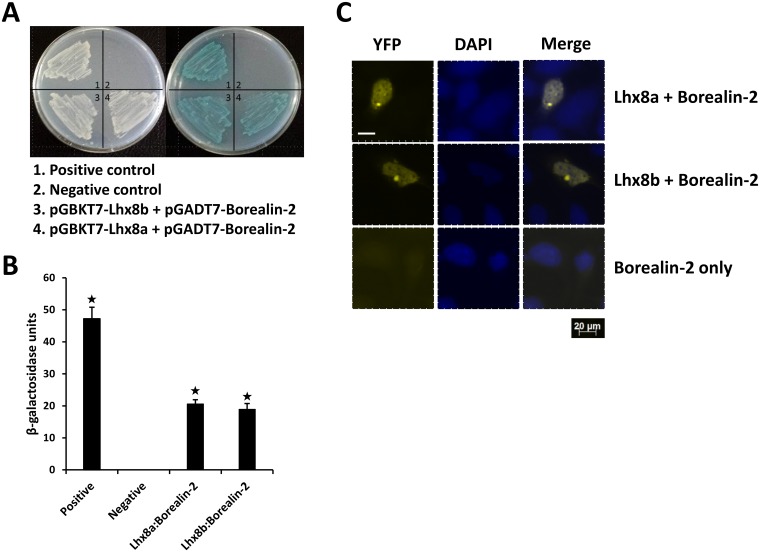
Analysis of interactions between Lhx8 proteins and Borealin-2.A: Yeast two-hybrid analysis showing growth of yeast cells expressing BD and AD fusion proteins. Left plate: growth of yeast cells on DDO plate (medium lacking Leucine and tryptophan) showing successful co-transformations. Right plate: growth of yeast cells on selective QDO/X/A plate (quadruple drop-out medium lacking leucine, tryptophan, adenine and histidine and containing X-gal and Aureobasidin A) indicating protein-protein interactions. B: Yeast β-galactosidase liquid assays confirming interactions between Lhx8 proteins and Borealin-2. Asterisks indicate significant difference (P<0.05). C: BiFC analysis showing interactions between Lhx8 proteins and Borealin-2. HEK293 cells were co-transfected with equal amounts of BiFC expression constructs encoding VN-Lhx8a and VC-Borealin-2, or VN-Lhx8b and VC-Borealin-2 fusion proteins. Single transfection using the construct encoding VC-Borealin-2 was served as a negative control. YFP signals due to BiFC were measured by fluorescence microscopy. Scale bars, 20 μm.